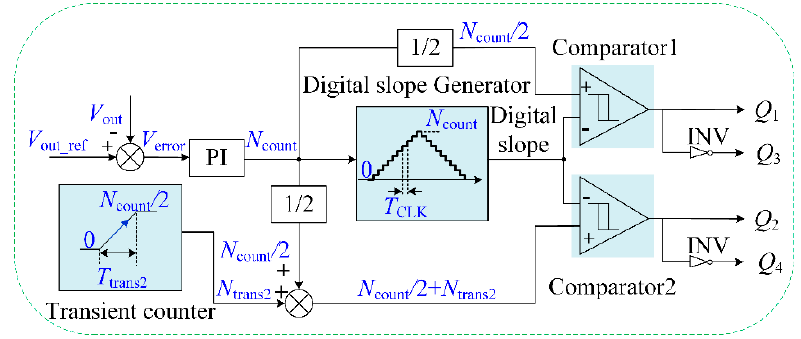
Figure 7. Digital implementation block diagram for transient switching process b.